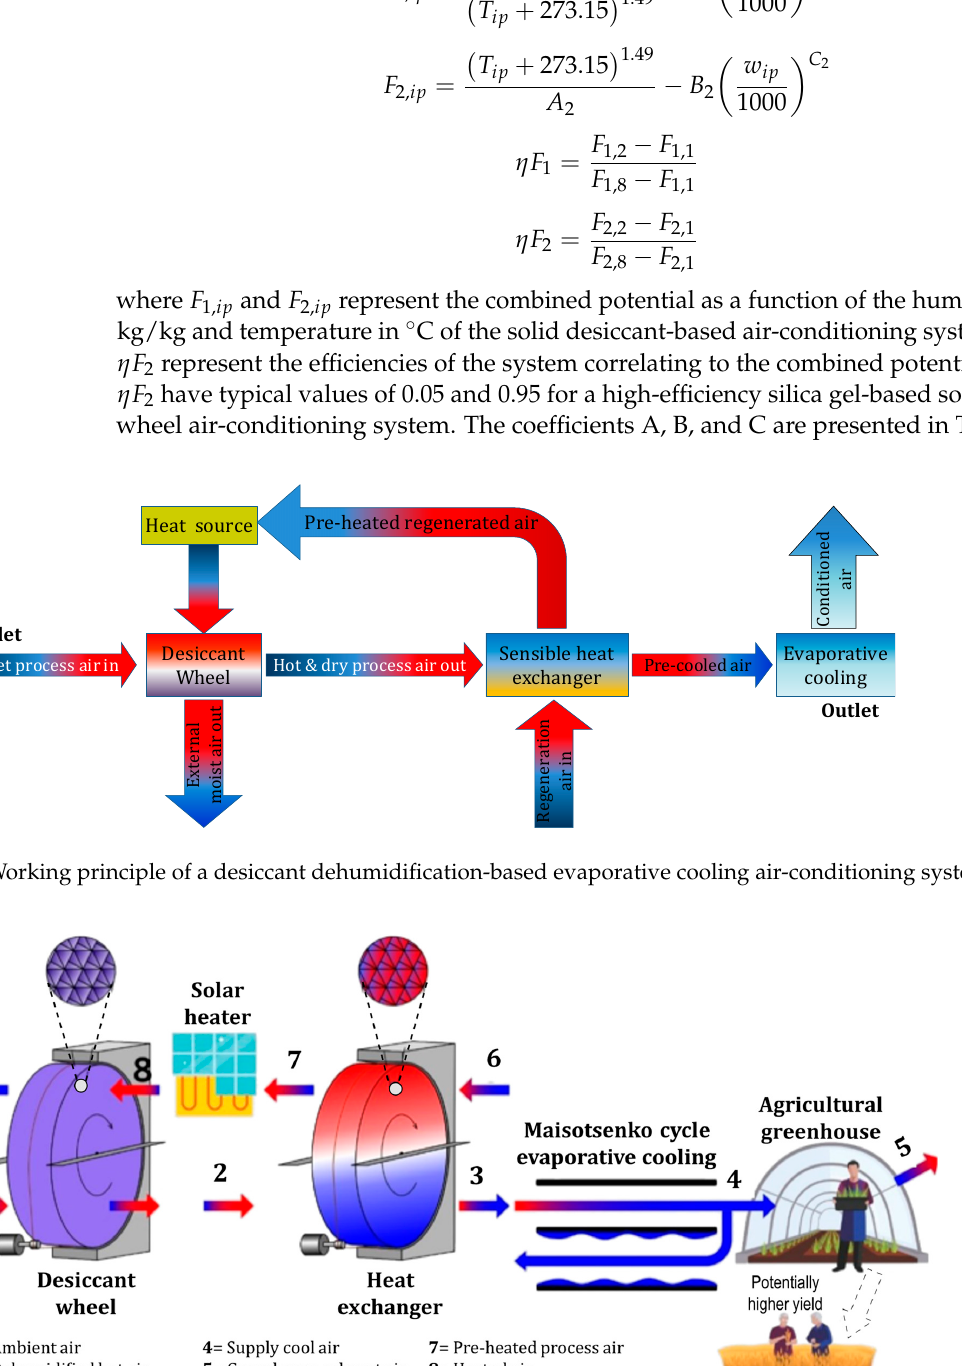
Figure 5. Schematic diagram and working principle of the proposed desiccant dehumidification Maisotsenko cycle evap- orative cooling system.